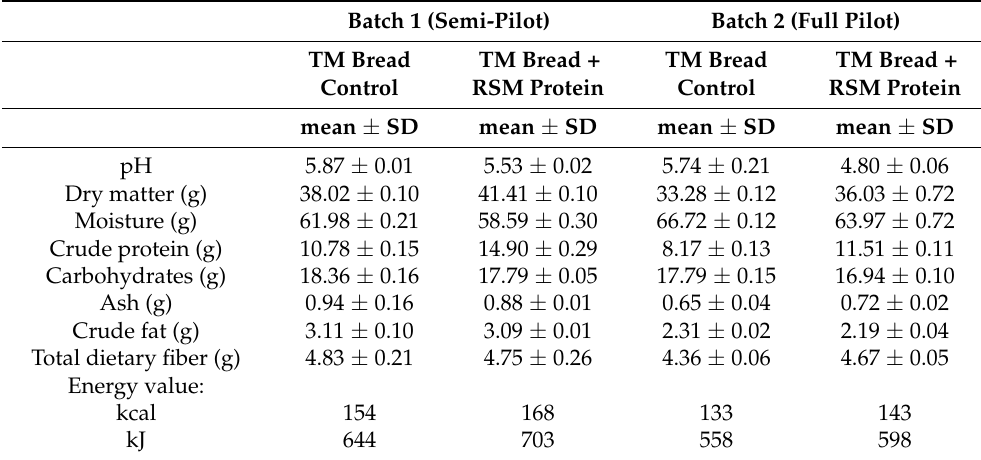
Table 7. Macronutrient composition and energy value of TM bread: control and RSM-protein- supplemented (5% w/w ) samples. Values are expressed per 100 g of fresh product.